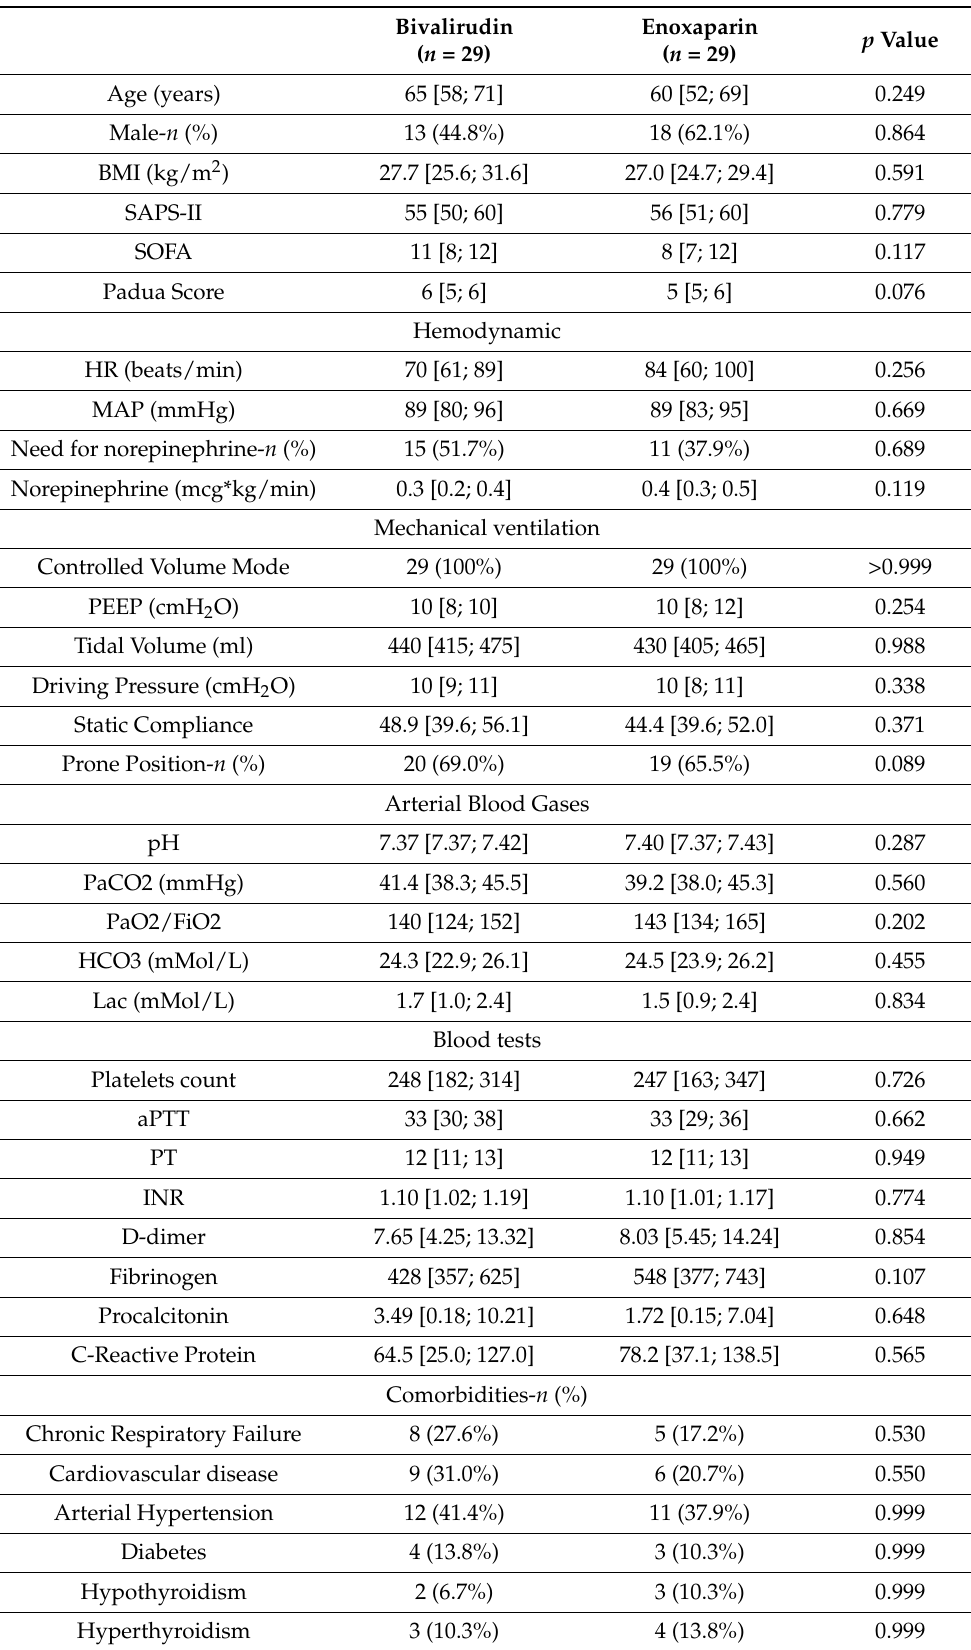
Table 1. Characteristics of the study